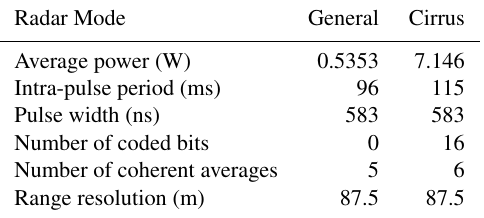
Table 4. Radar operational mode configuration settings. The radar cycles between four modes of which only the cirrus and general modes are used in this work. The modes are cycled such that the general mode is every fourth measurement and the cirrus mode is every eight at a cadence of approximately 0.5s per